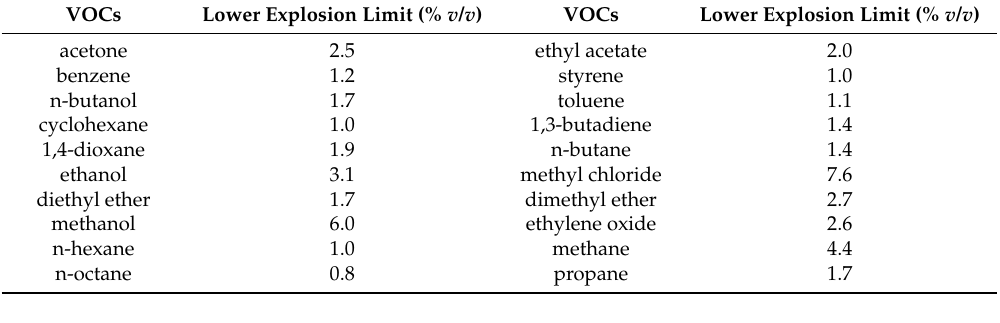
Table 2. Lower explosion limit for selected VOCs.